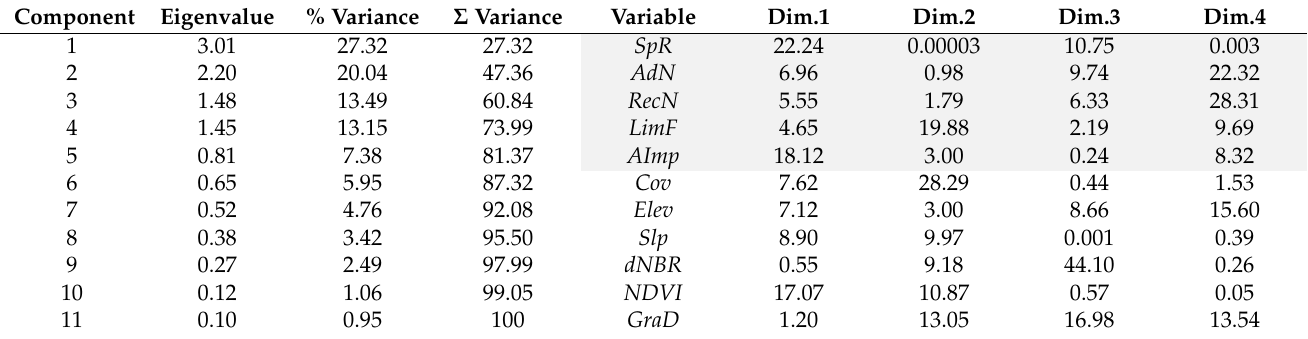
Table 4. PCA obtained results. Contribution of the variables included in the habitat quality index (HQI) appears highlighted in grey. SpR : focal species richness, AdN : No. of adults and sub-adults, RecN : No. of saplings and juveniles, LimF : limiting factors, AImp : anthropogenic impacts, Cov :